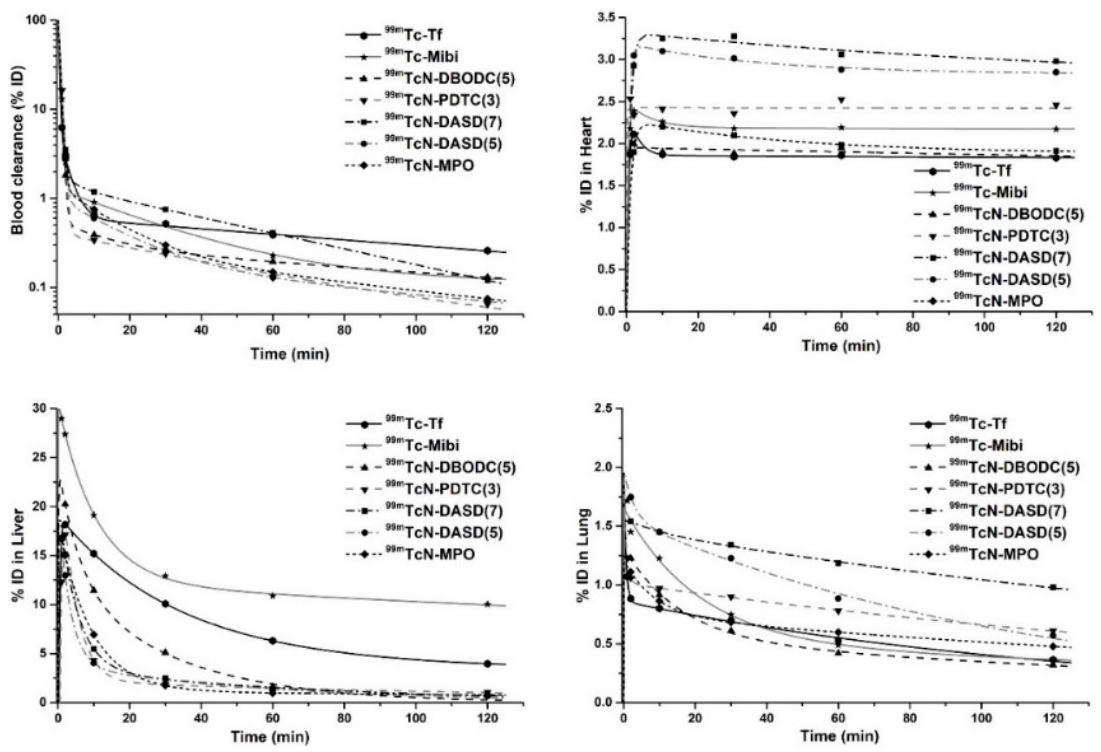
Figure 13. Time–activity curves of [ 99m Tc][TcN(L)(PNP)] + in the main organs compared with those of commercially available MPIAs.